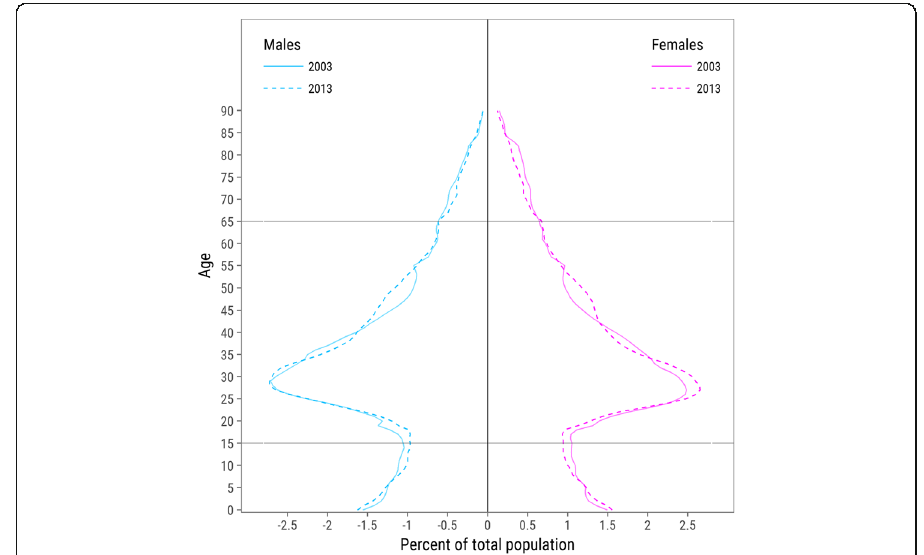
Fig. 10 Population pyramids of London in 2003 and 2013